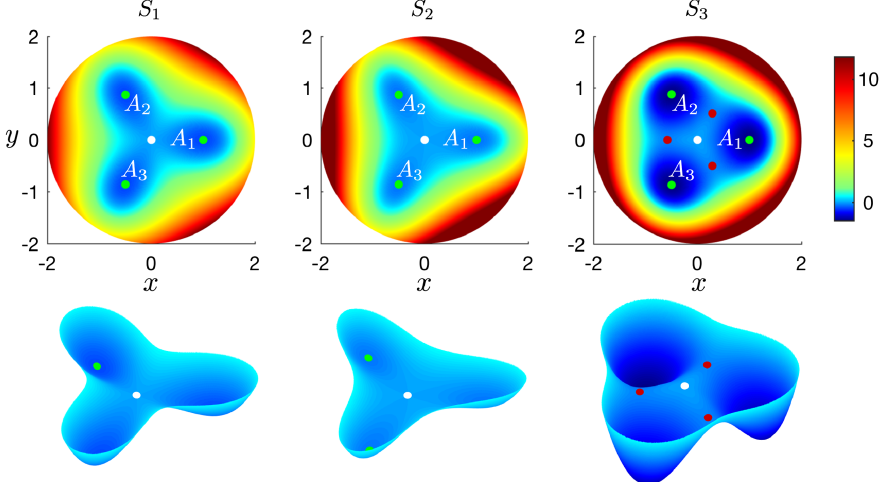
FIG. 3. Three shapes of the roulette surface that we consider, given by the functions S 1 , S 2 , and S 3 defined in the text. In each panel, the white dot indicates the unstable fixed point at the origin, the green dots the attractors ( A 1 , A 2 , and A 3 ), and the red dots the saddle points away from the origin (only present for S 3 ). The part of each surface corresponding to S i ð r; θ Þ < 0 . 5 is shown in the bottom row. Surface colors indicate the value of the function, and a common color scheme is used in all six